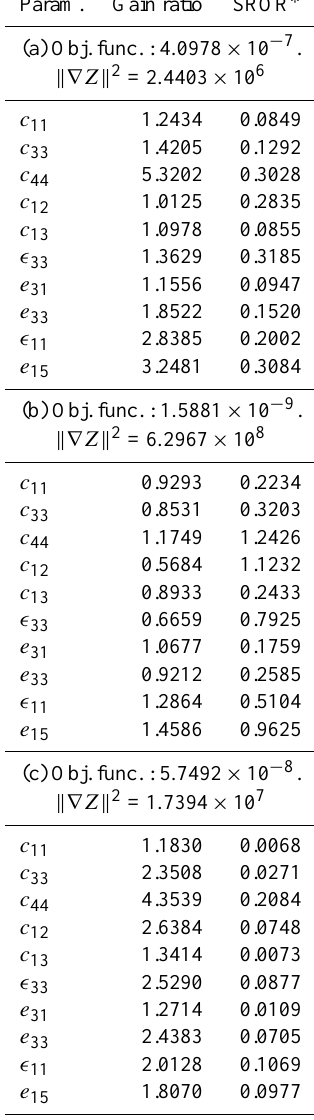
Table 4. Different starting configurations with uniform √ · diag(1 ,..., 1 , 2). With 2